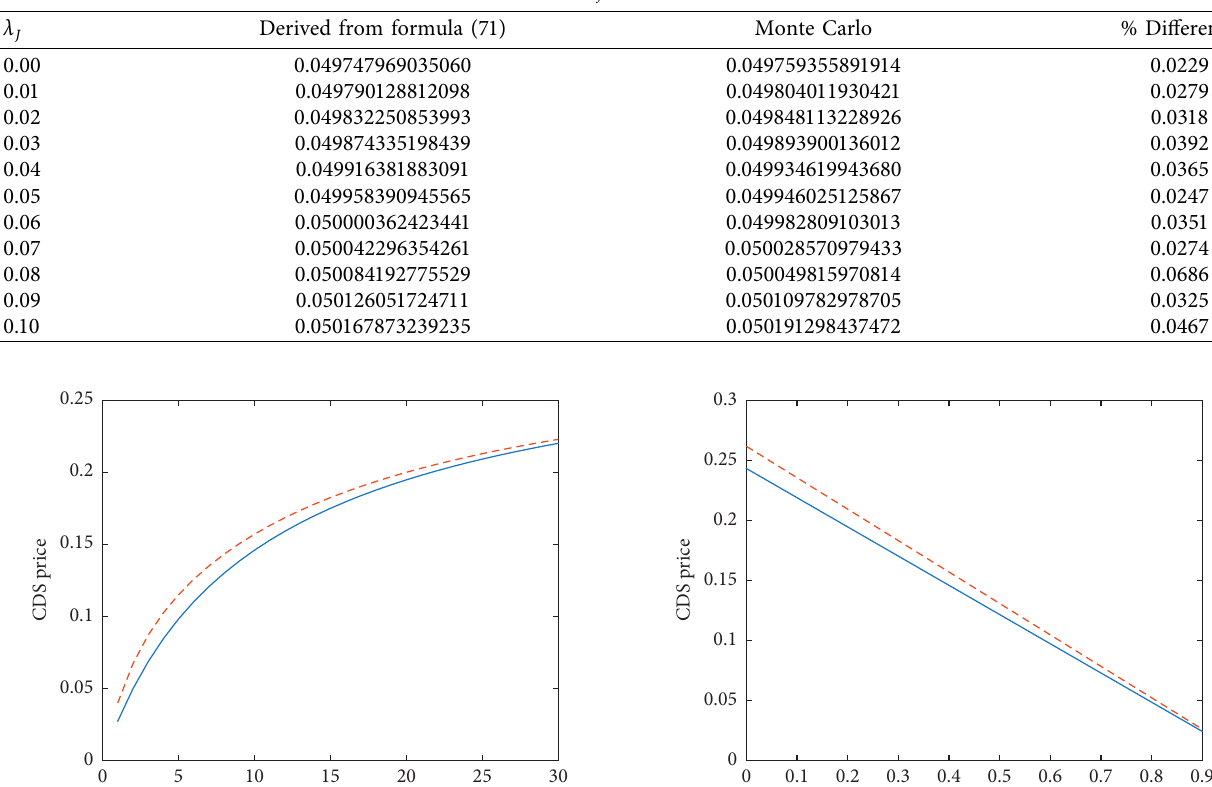
� 0 . 5 ,b � 0 . 1 , σ � 0 . 05 , ρ � 0 . 3 ( i ≠ j ) , λ ( t ) � 0 . 1 , ε � 0 . 01. i i i i i ij